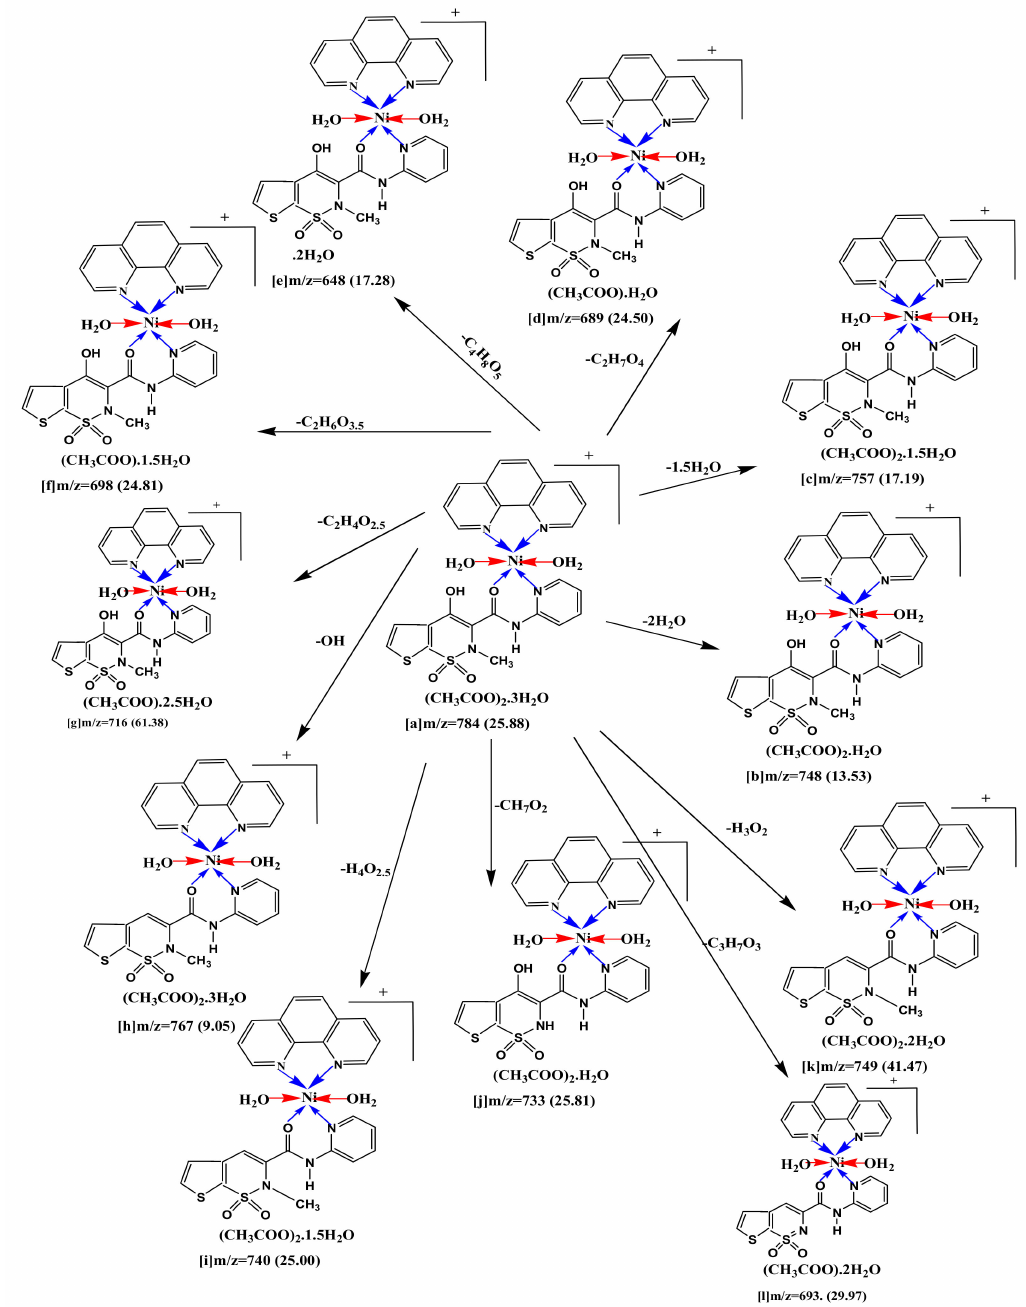
Scheme 3. Fragmentation pattern of (C)